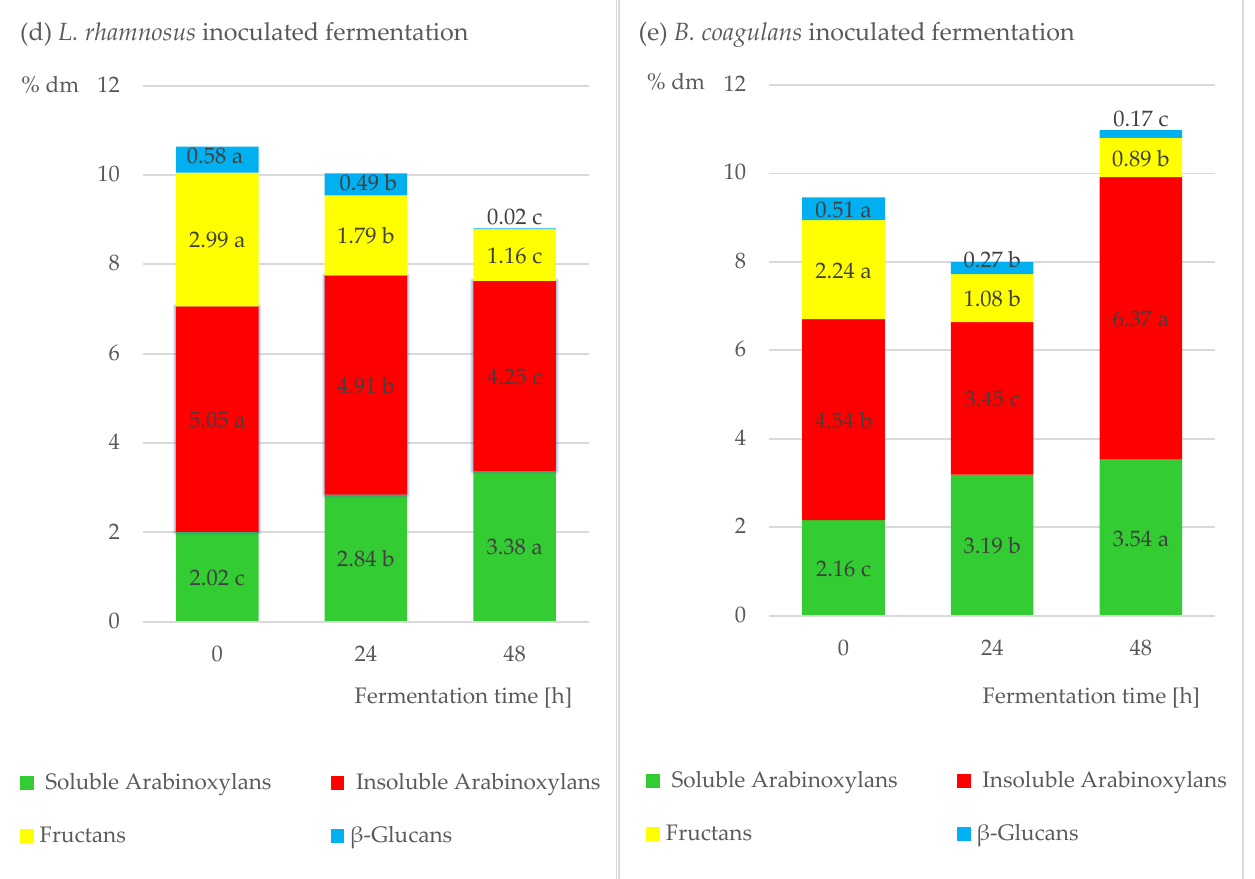
Values represent the means of two replicates. Lowercase letters indicate homogeneous groups determined using the Duncan test. Figure 1. The content of dietary fiber components in the sourdough during fermentation [%]: ( a ) spontaneous fermentation; ( b ) S. boulardii inoculated fermentation; ( c ) Lpb. plantarum inoculated fermentation; ( d ) L. rhamnosus inoculated fermentation; ( e ) B. coagulans inoculated fermentation.